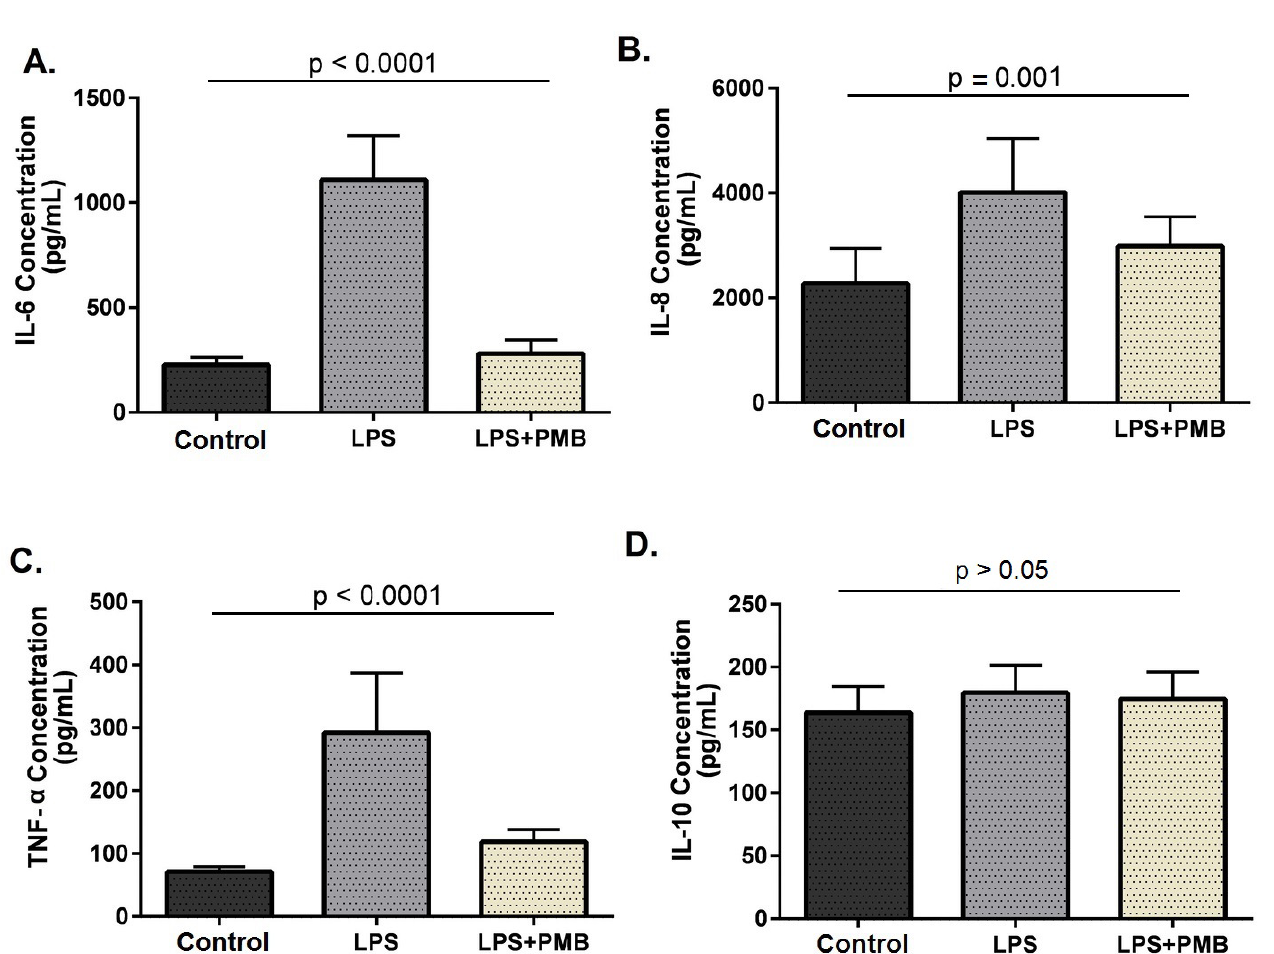
FIGURE 1 - Inhibition of Lipopolysaccharide (LPS) by polymyxin B (PMB). PBMCs isolated from study subjects (by ELISA). (A) IL-6 levels, (B) IL-8 levels, (C) TNF- α levels, and (D) IL-10 levels from study subjects. (A-D) The results are represented as Mean ± SEM. Statistical comparisons made by Kruskal-Wallis test, differences were considered statistically significant for